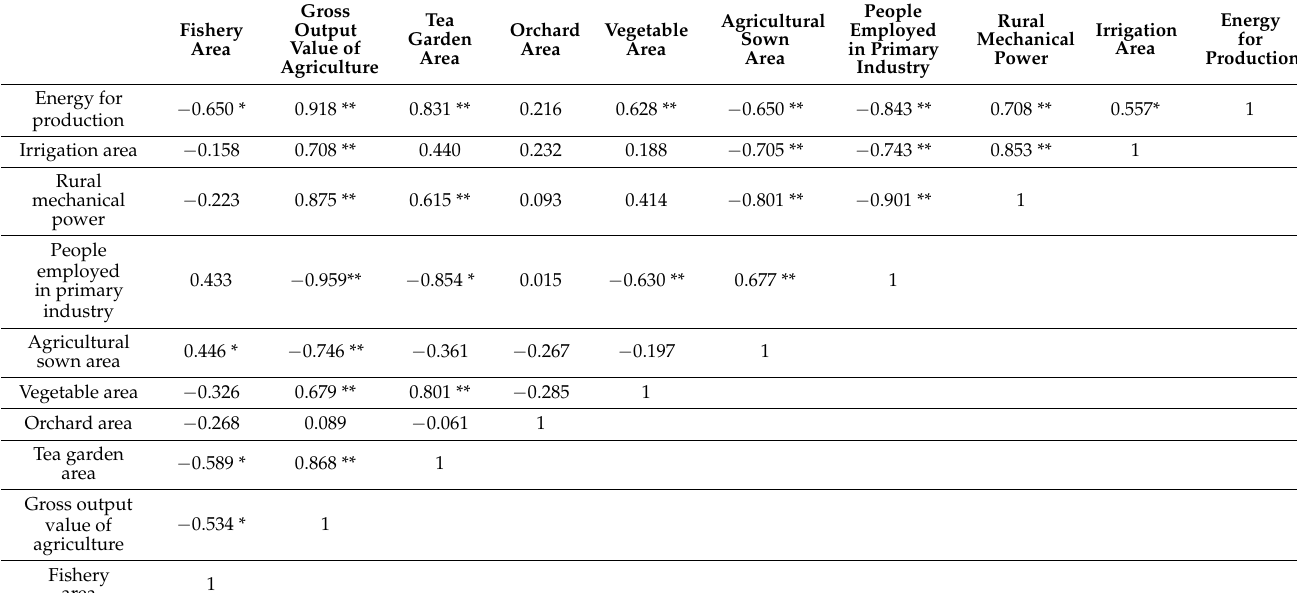
Table 2. Analysis of factors influencing energy consumption in rural agriculture production in